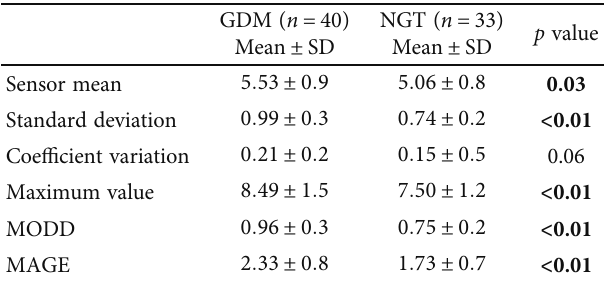
Table 3: Comparison of glycaemic variability at CGM of GDM and NGT